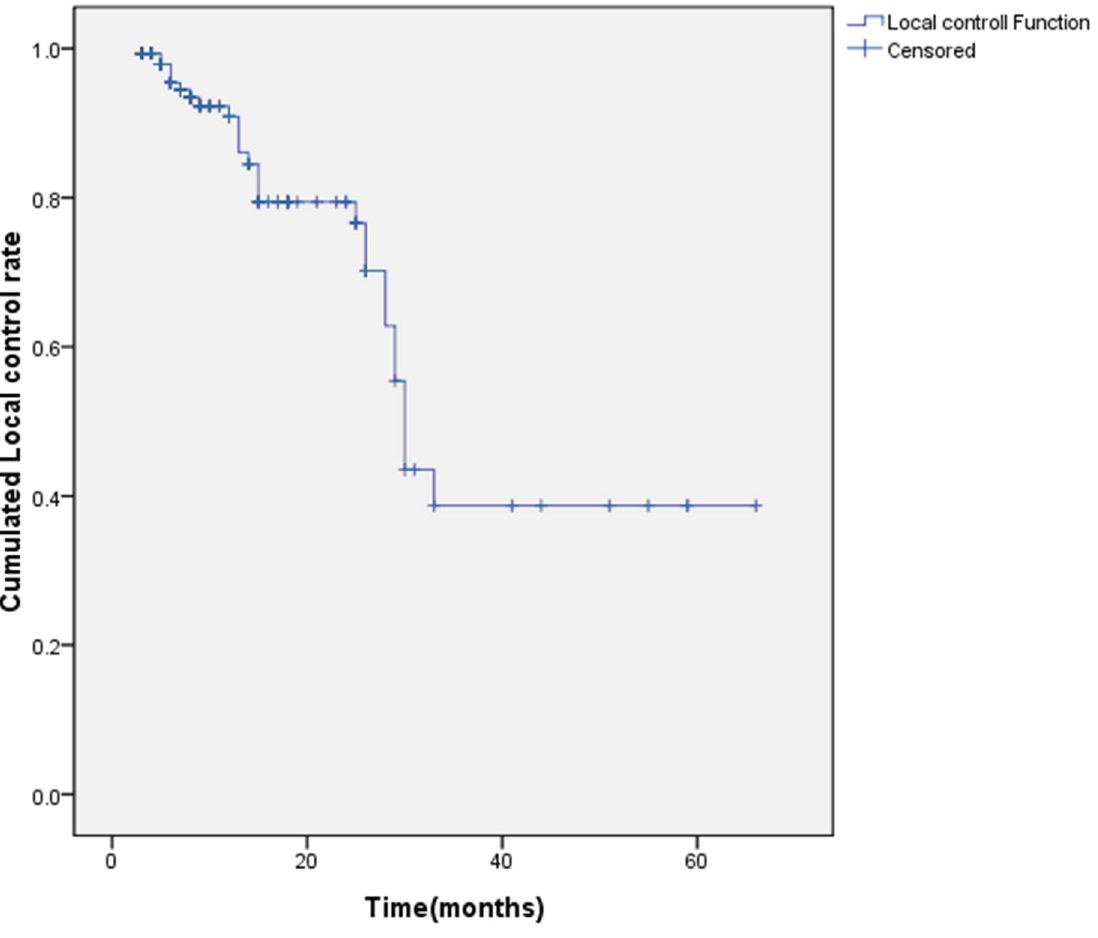
Fig 1. The cumulative rate of local control